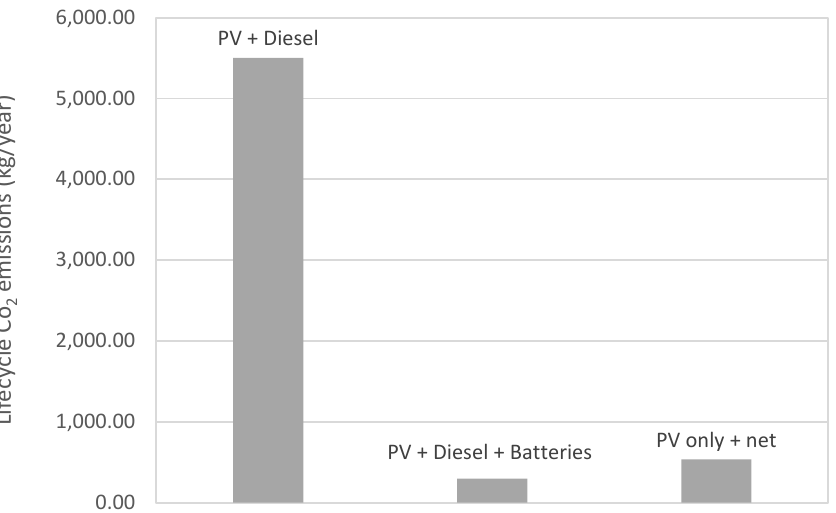
Figure 14. Lifecycle CO 2 emissions of the different schemes. All the cases represented.